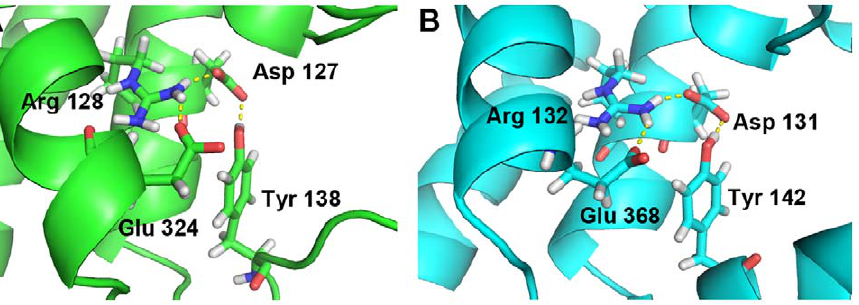
Figure 5. Ionic-look, structural marker of inactive state of G-protein Coupled Receptors. (A) hD 3 and (B) hD 2L receptor.